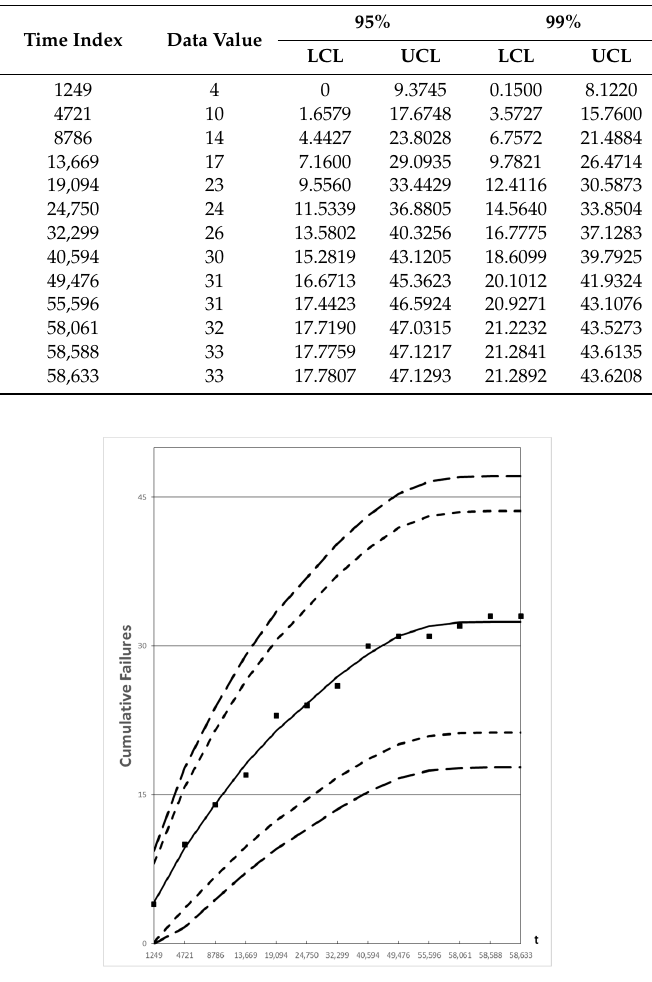
Figure 8. 95% and 99% confidence intervals for the proposed model for dataset #2.